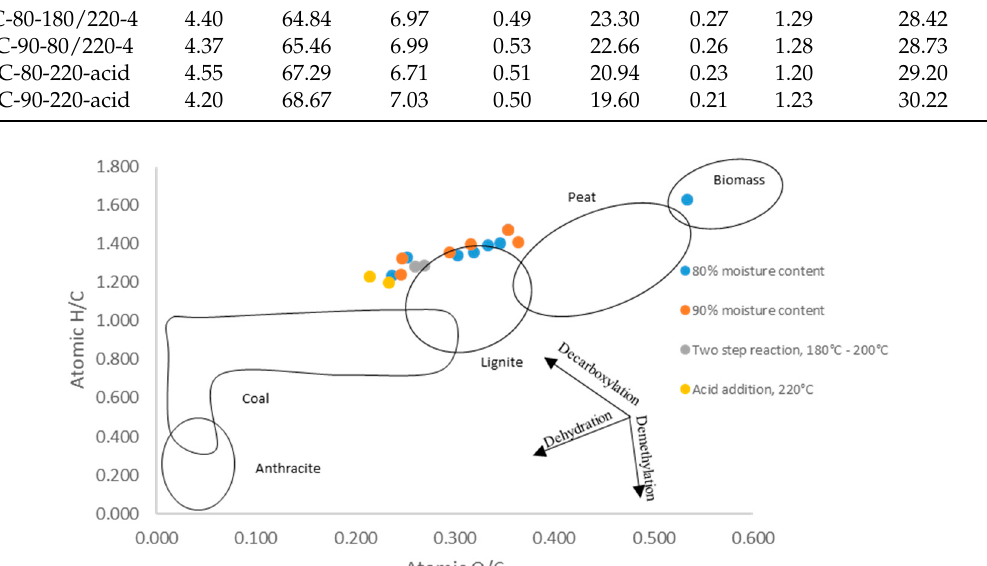
Figure 2. Van Krevelen diagram for hydrochars versus temperature, residence time and moisture